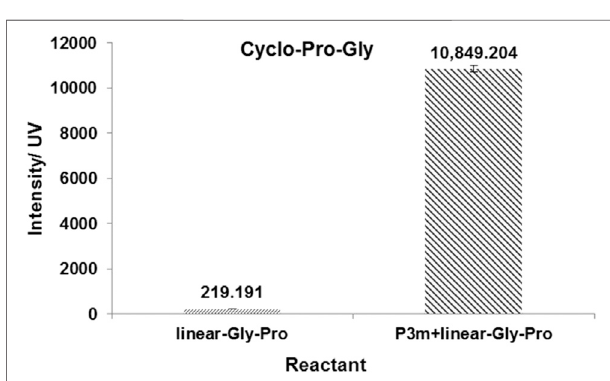
FIGURE 3 | Effects of P 3 m on the formation of cyclo-Pro-Gly in the reaction of linear-Gly-Pro with or without the presence of P 3 m. All reactions were controlled under standard